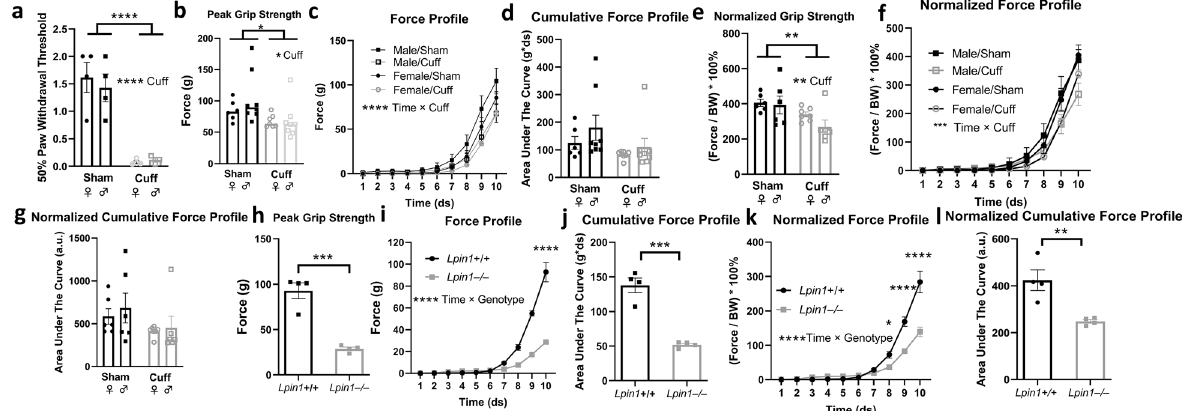
Figure 2. Differential effects of localized ( a – g ) and generalized peripheral nerve impairment ( h – l ) on muscle strength parameters. ( a ) Following recovery from sciatic nerve entrapment surgery (cuff), paw withdrawal thresholds are reduced (****p < 0.0001, Student’s t-test). ( b ) Peak grip strength is reduced in cuffed animals (*p < 0.05, Two-way ANOVA). ( c ) Force profile is reduced in animals exposed to cuff in both sexes. (****p < 0.0001, time × cuff interaction, Tukey’s multiple comparison three-way ANOVA; Female/Sham n = 6, Male/Sham n = 8, Female/Cuff n = 7, Male/Cuff n = 8). ( d ) Cumulative force profile is unchanged in either sex following cuff. ( e ) Normalizing grip strength to the body weight (BW) does not alter the differences seen following cuff. ( f ) Force profile normalized to BW is reduced in cuffed animals (****p < 0.0001, time × cuff interaction, Tukey’s multiple comparison three-way ANOVA Female/Sham n = 6, Male/Sham n = 6, Female/Cuff n = 7, Male/Cuff n = 6). ( g ) BW-normalized cumulative force profile is unchanged following cuff. ( h , i ) Lpin1 –/– animals have reduced grip strength, force profile(**p < 0.01, Student’s t-test; * p < 0.05, **p < 0.01, ****p < 0.0001, time × genotype interaction, two-way repeated measures ANOVA; n = 4/group) and ( j ) cumulative force profile (***p < 0.001, Student’s t-test). ( k , l ) Lpin1 –/– mice exhibit reduced force profile and cumulative force profile after